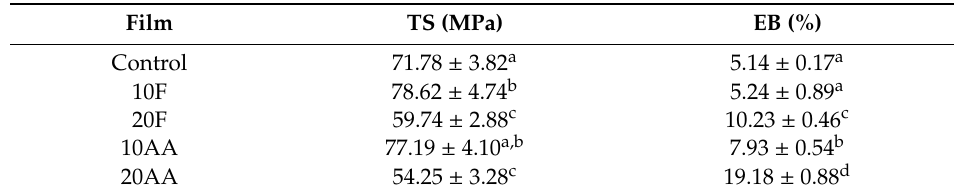
Table 4. Tensile strength (TS) and elongation at break (EB) of gelatin films as a function of cross-linker type and content.